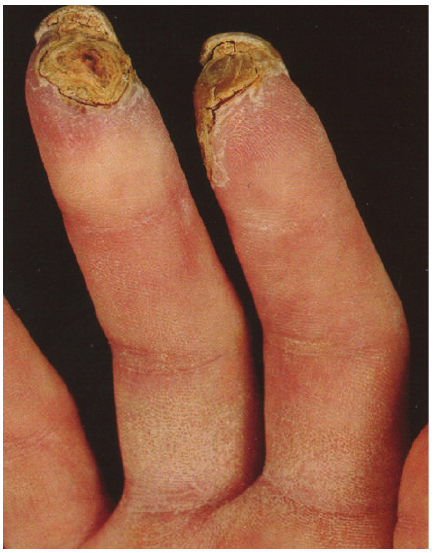
Figure 10: Raynaud’s phenomenon [9, page 405].